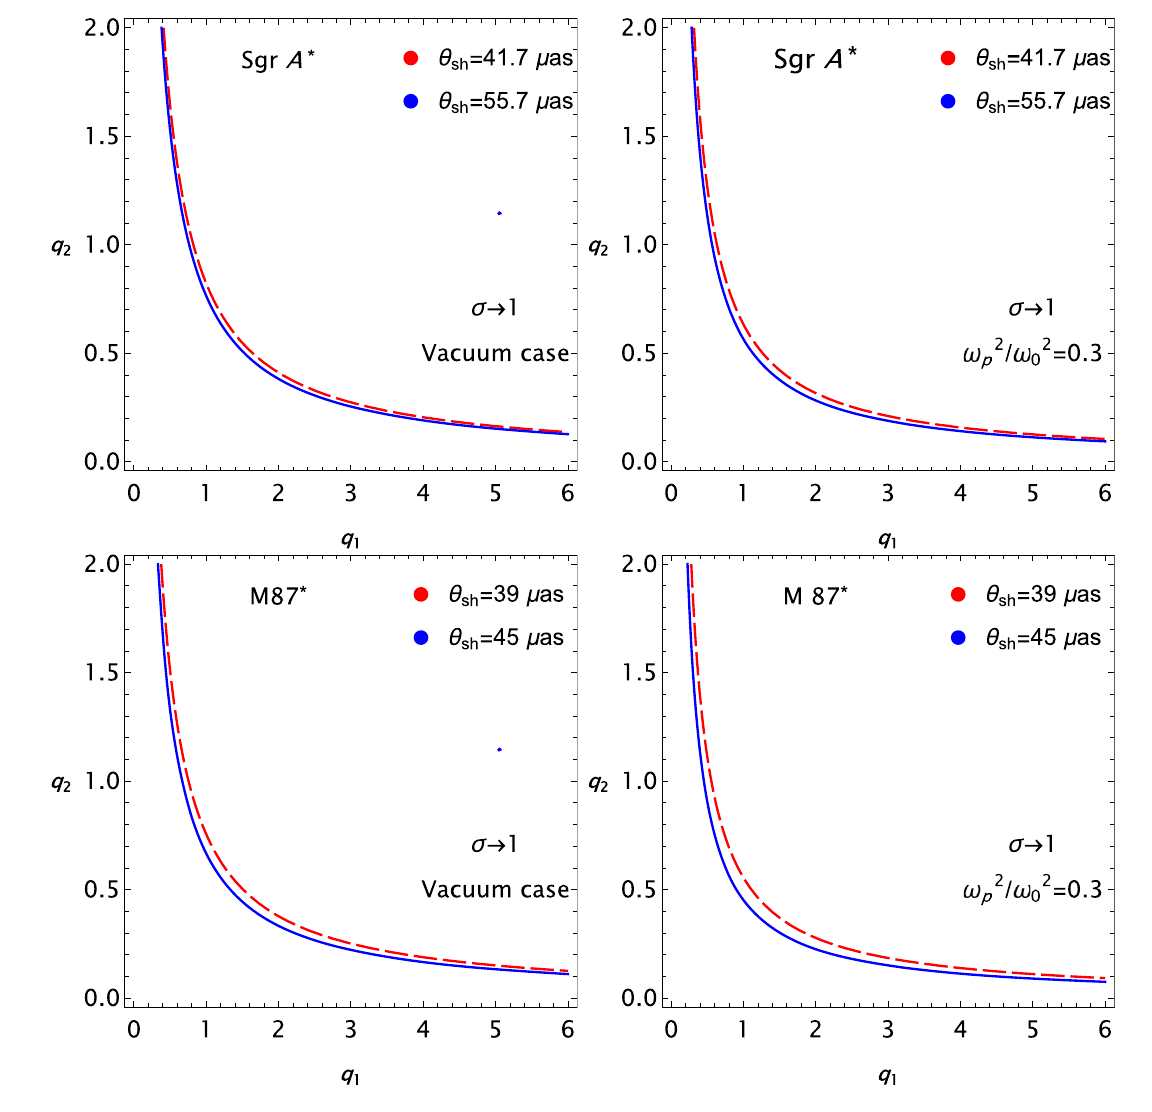
Fig. 14 The same as Fig.13 but for σ →